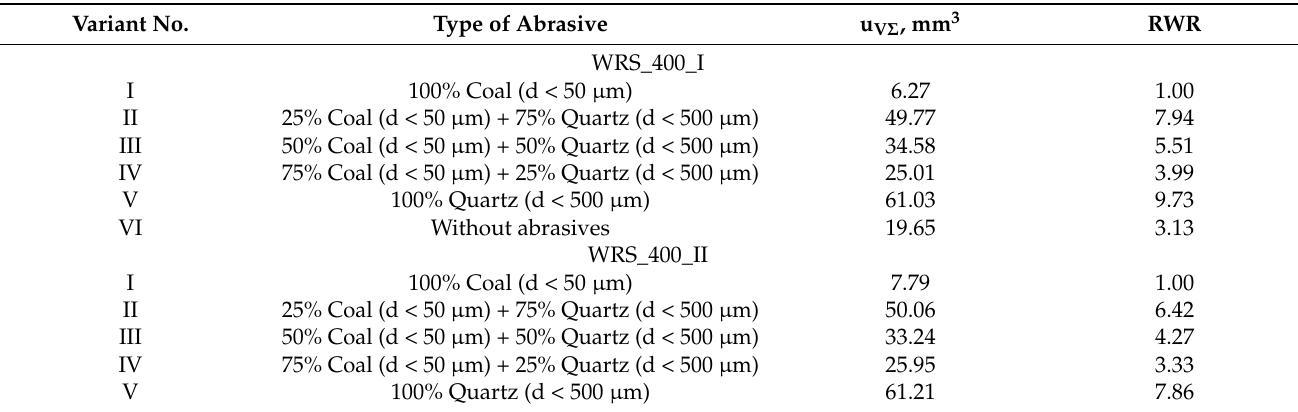
Figure 9. Views of the surface layer cracks in the area the side of roller of WRS_400_I steel’s sample. Table 6. Total mass wear u V Σ for the discussed